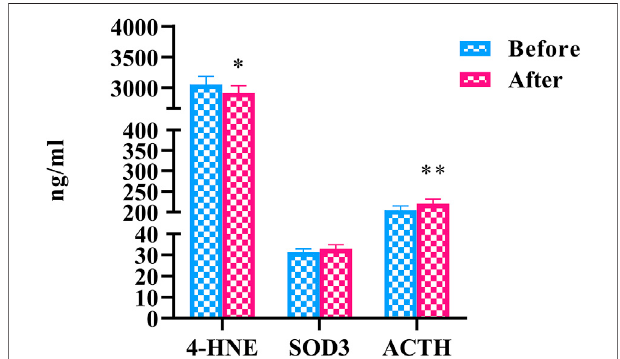
FIGURE 3 | The changes of oxidative stress factors before and after HLJDD intervention (Before) Oral disease group (After) HLJDD intervention group (* p < 0.05, ** p <